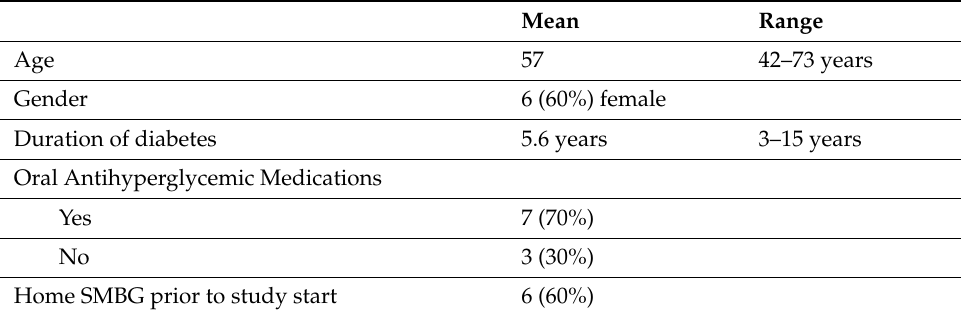
Figure 2. Consort Diagram. Table 1. Participant characteristics at baseline. Table 1. Participant characteristics at